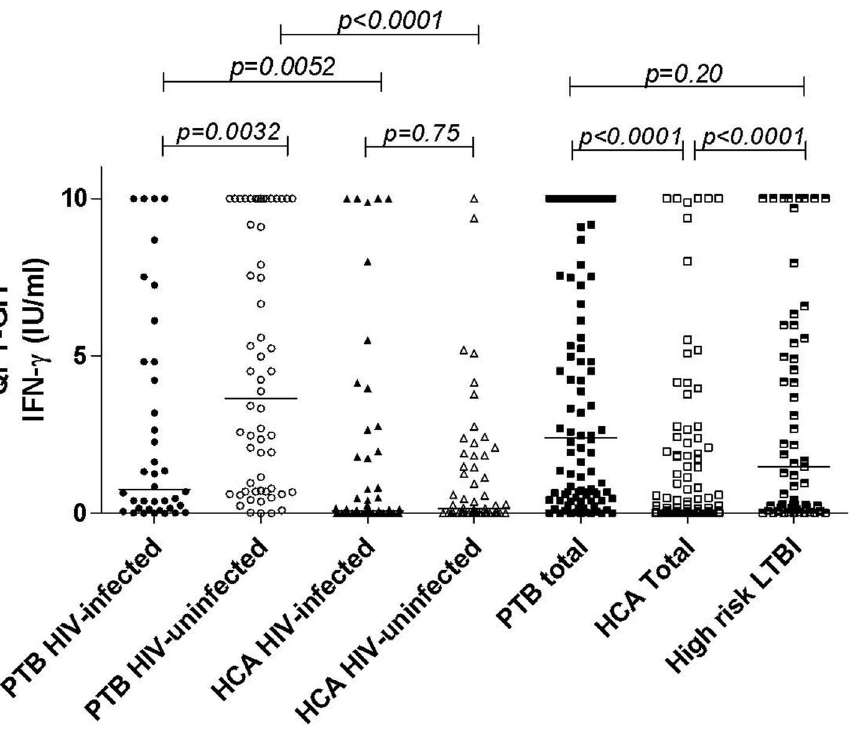
Figure 2. Individual Interferon-gamma (IFN- c ) responses among 96 pulmonary TB (PTB) patients and 110 healthy community adults (HCA) stratified by HIV status and in a group of 59 healthy adults at high risk of M.tuberculosis exposure (54 recent family contacts and 5 health care workers). Short bars, median level of QFT-GIT response in each group. Footnotes: TB: tuberculosis; HIV: human immunodeficiency virus; LTBI: latent tuberculosis infection.